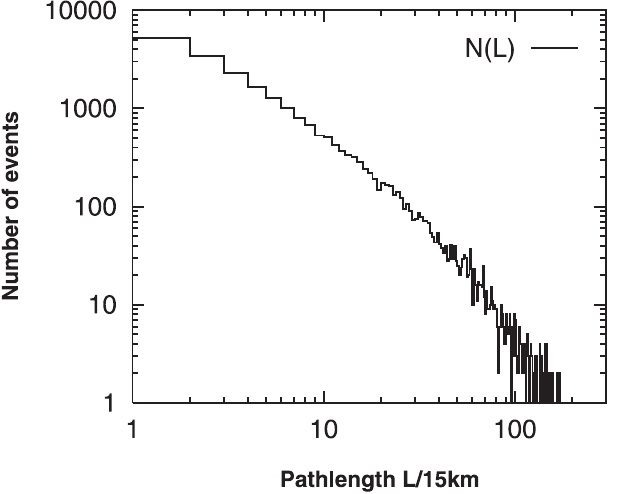
Fig. 1. Non-normalised statistical distribution, N (cid:133) L (cid:134) , of path lengths flown by MOZAIC aircraft within ice-supersaturated regions in the upper troposphere and lowermost stratosphere on flights between 1995 and